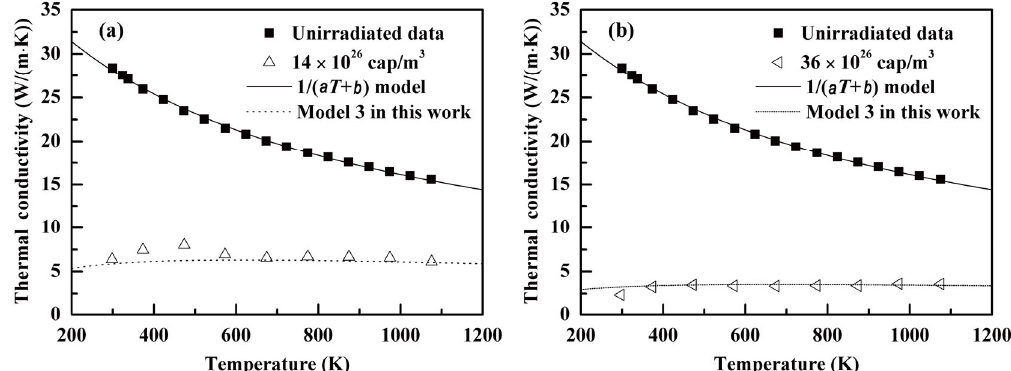
Fig. 4 Predicted thermal conductivities at different burnups by the model considering all the three types of irradiation-induced defects (Model 3) with comparison to the experimental data of the samples before and after irradiation by Maruyama et al .